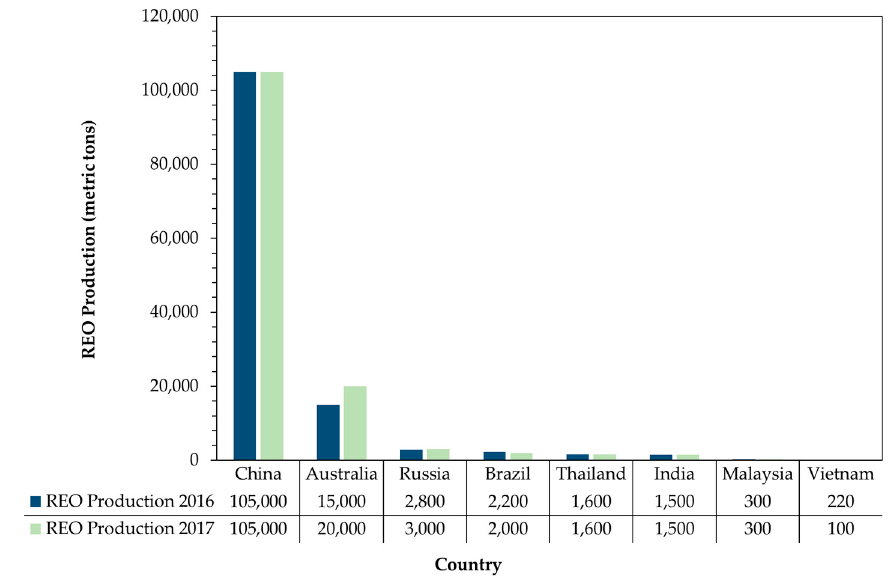
Figure 1. Rare earth production by country [33].